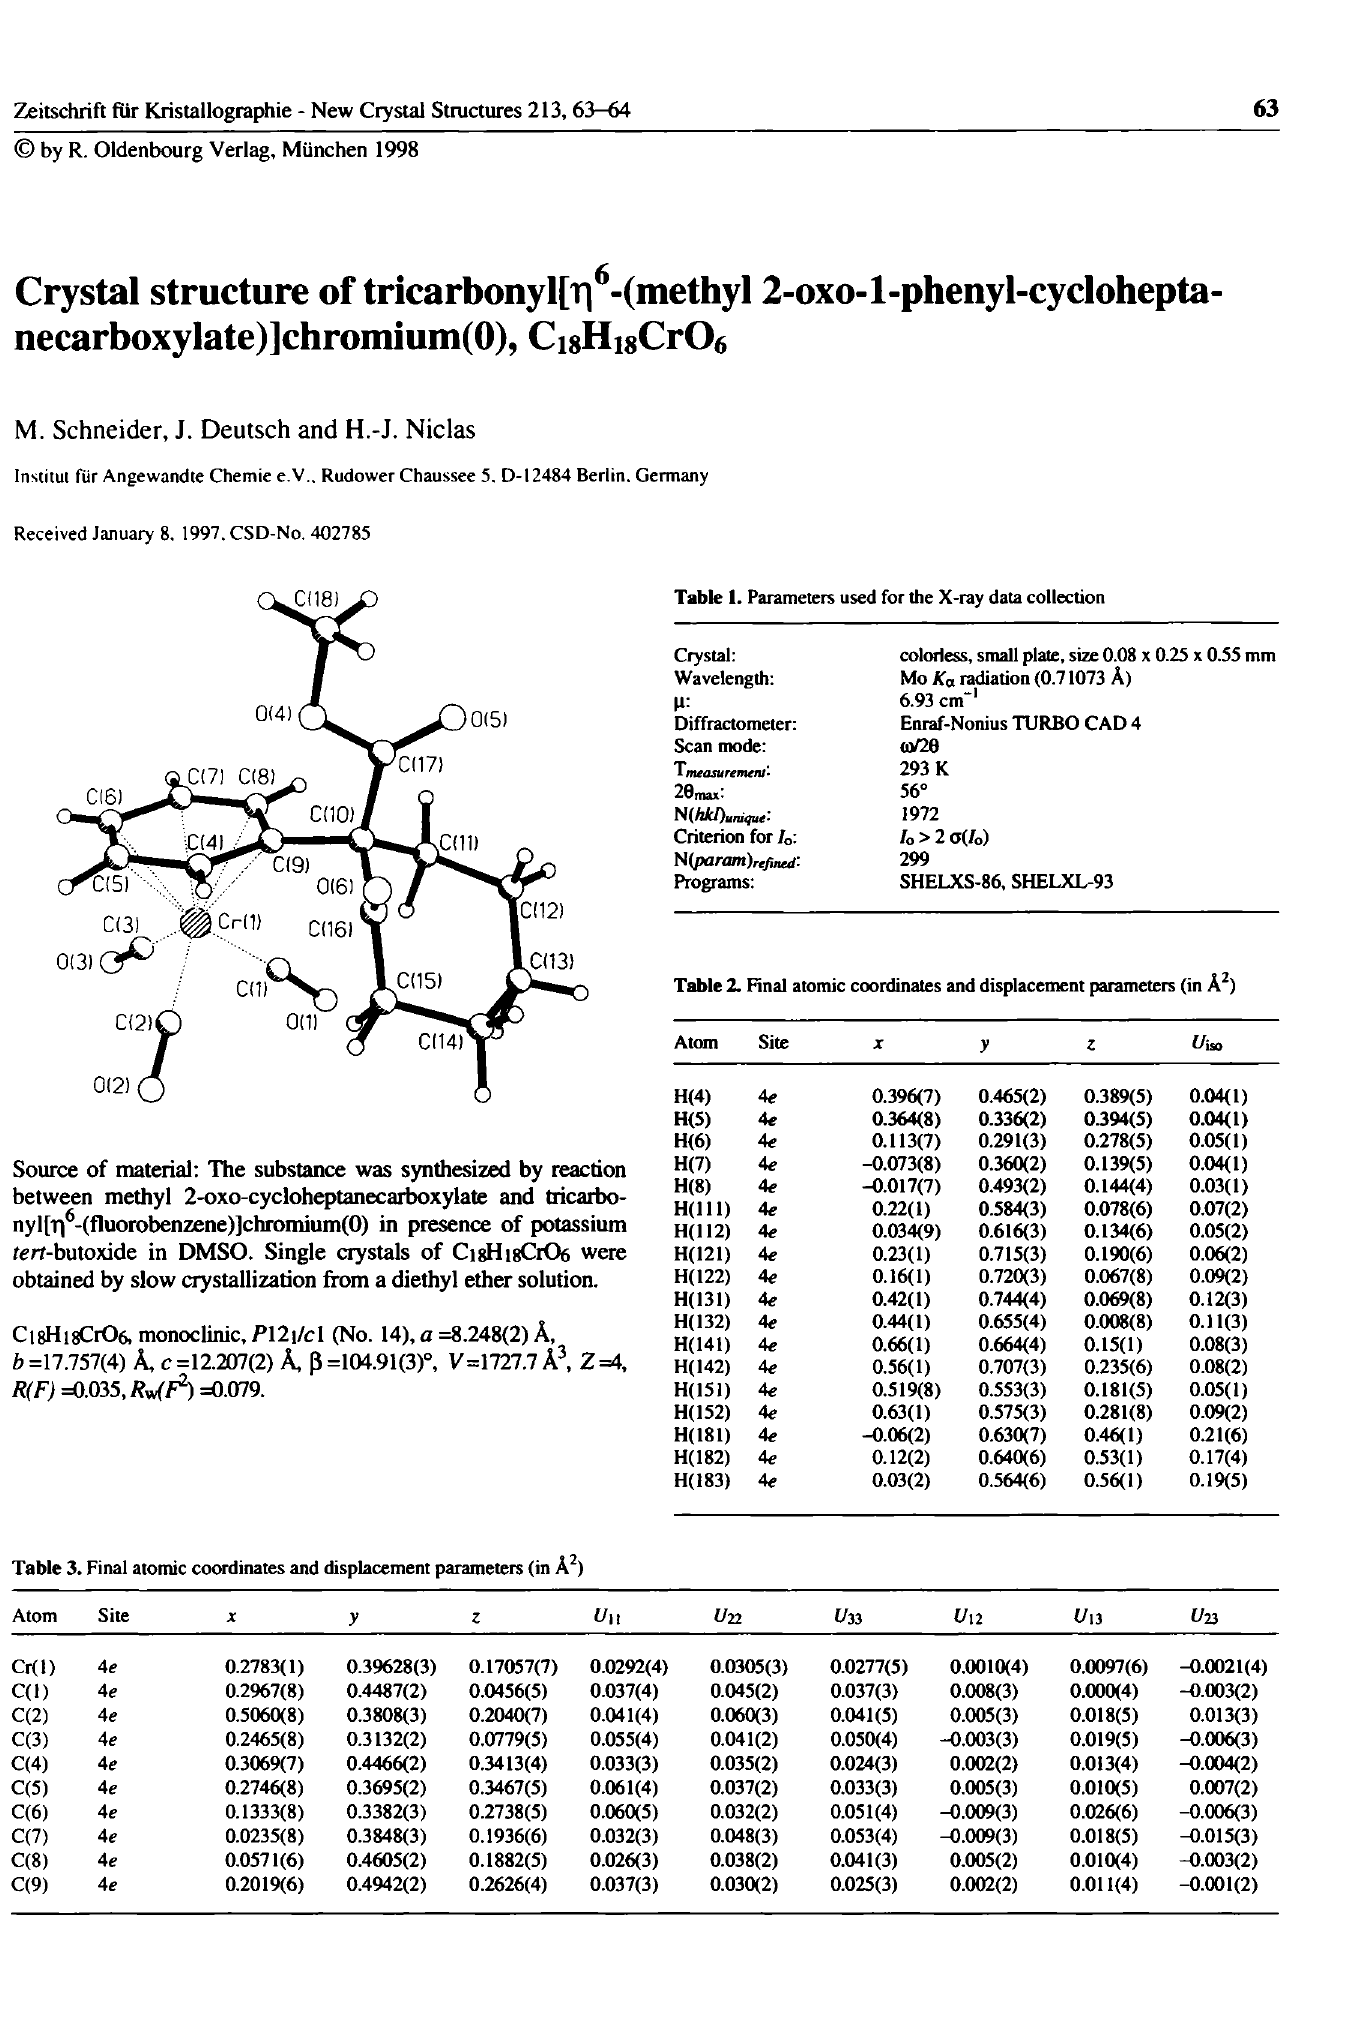
Table 3. Final atomic coordinates and displacement parameters (in A^)